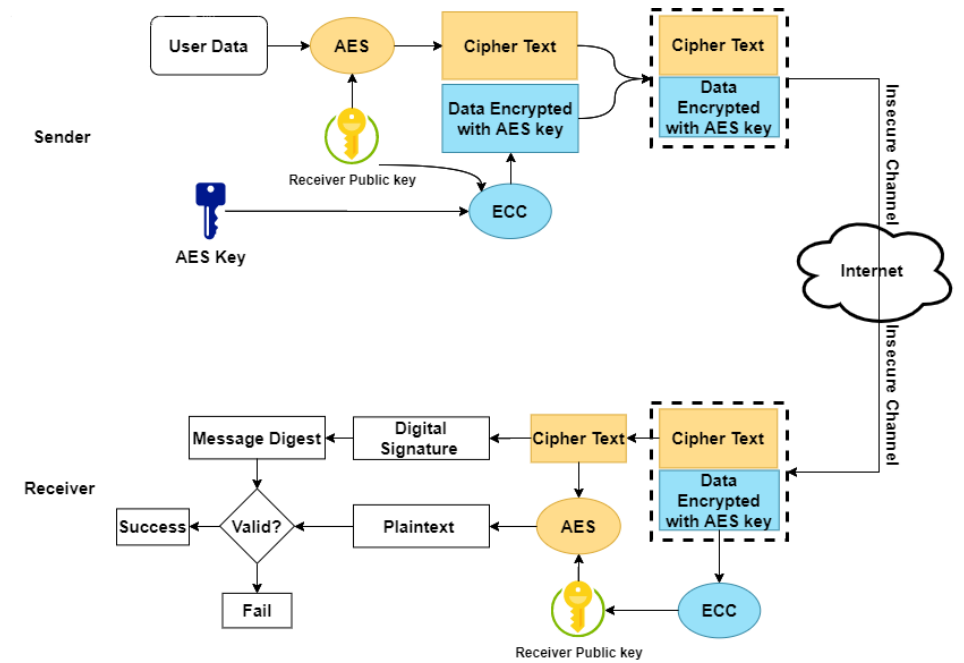
Figure 2. The workflow diagram of the AES-ECC